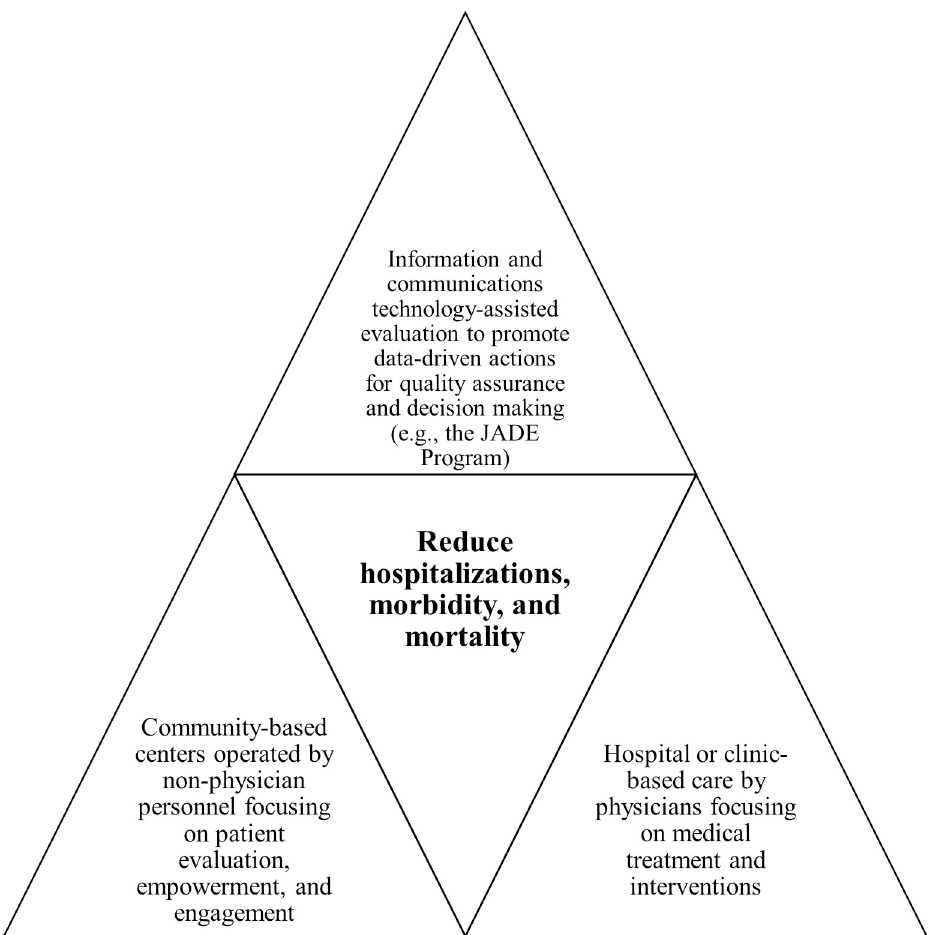
empower, and engage patients for providing quality assurance and complementing physician care. ICT, information and communications technology; JADE, Joint Asia Diabetes